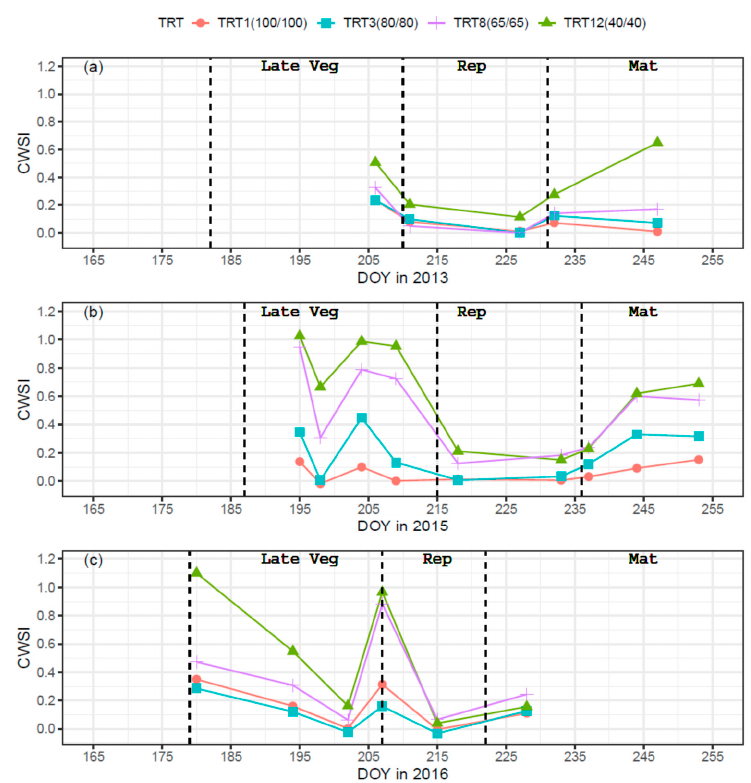
Figure 5. Time series of crop water stress index (CWSI) for TRT1(100/100), TRT3(80/80), TRT8(65/65), and TRT12(40/40) in the 2013 ( a ), 2015 ( b ), and 2016 ( c ) growing seasons. The black dotted lines are boundaries between different growing stages. Late Veg, Rep, and Mat are the abbreviations for late vegetative, reproductive, and maturation stages, respectively.